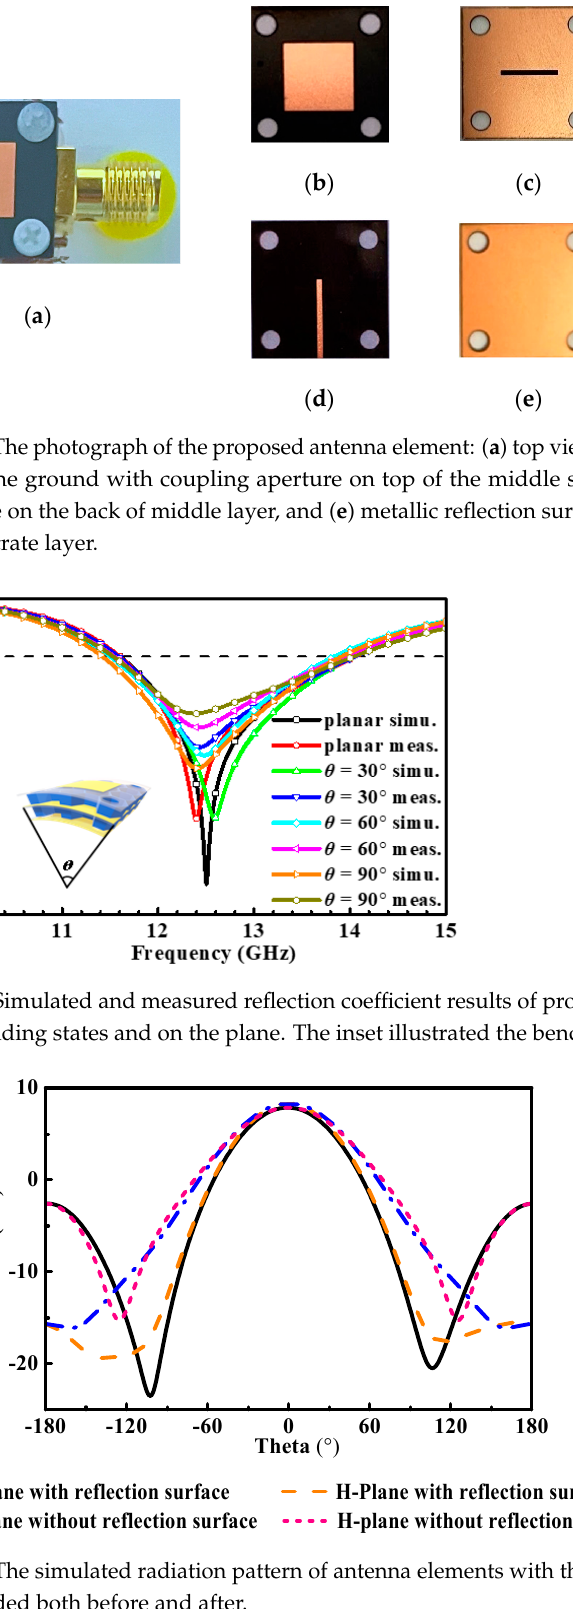
Figure 14. Simulated and measured results for gain radiation patterns and cross-polarization radi- ation patterns of the proposed antenna element in flat state and under various bending states at 12.5 GHz, ( a – h ) E-plane and H-plane with various states.